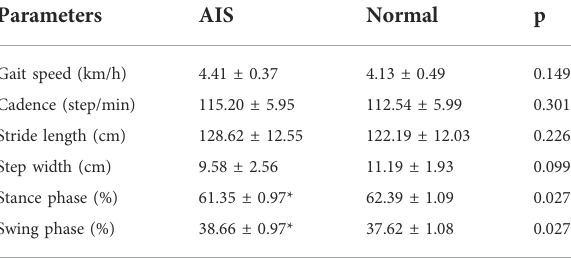
TABLE 3 Gait parameters in adolescent idiopathic scoliosis (AIS) and normal subjects ( n = 34).